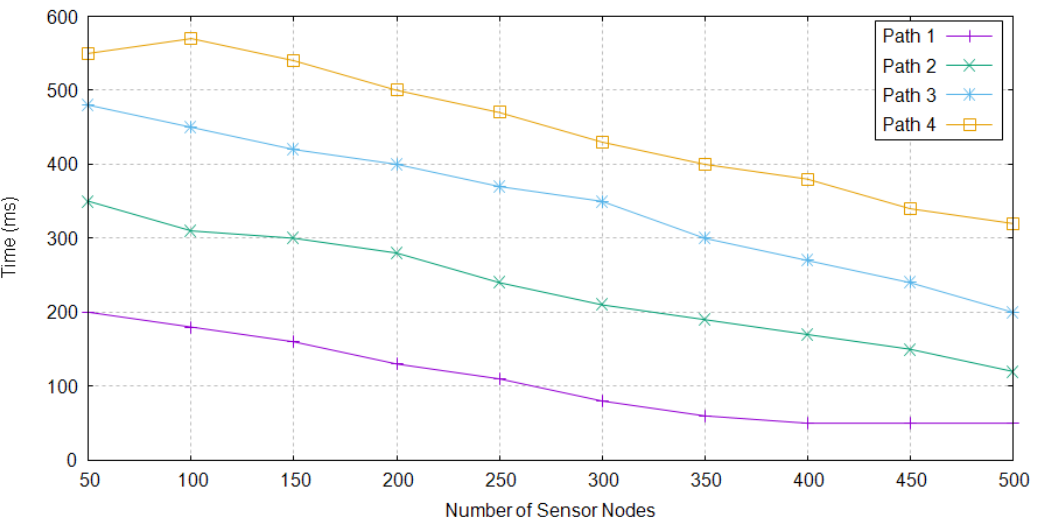
Figure 7. Reliable Paths Creation Time in